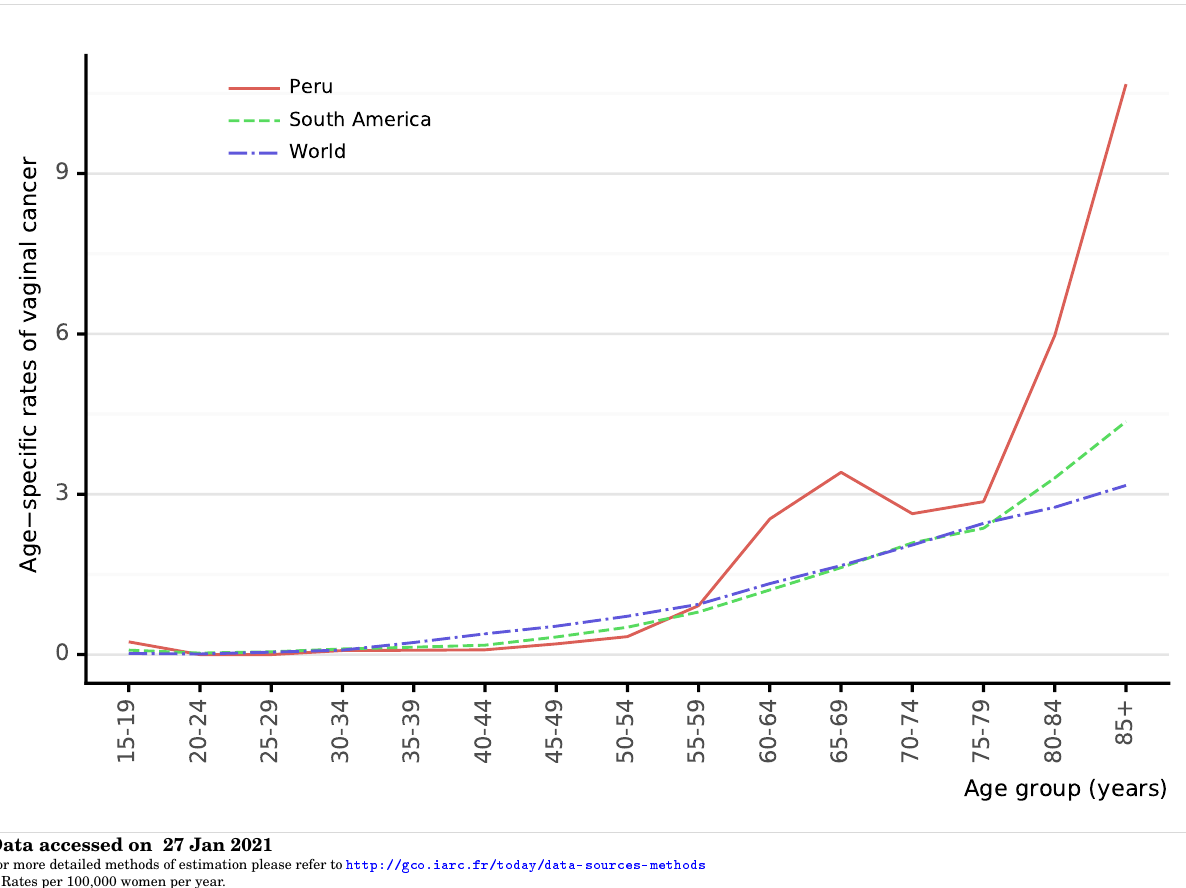
Figure 86: Comparison of age-specific vaginal cancer incidence rates in Peru, within the region, and the rest of